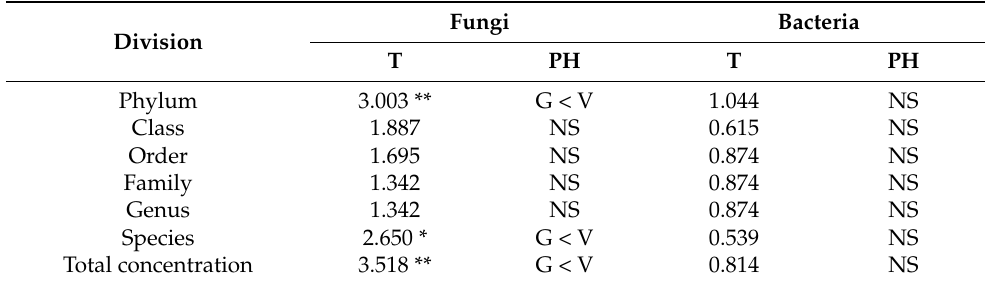
Table 7. Results of statistical analyses according to the type of greenhouse. Division